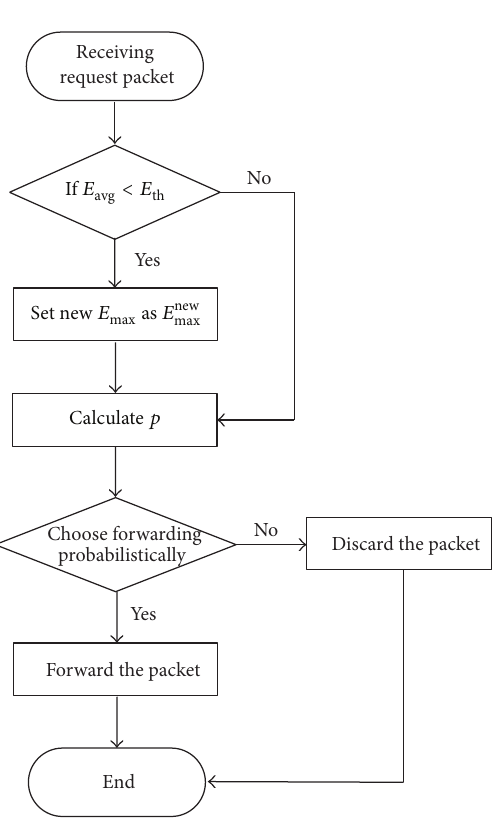
Figure 5: Flow chart of the advanced EEPR